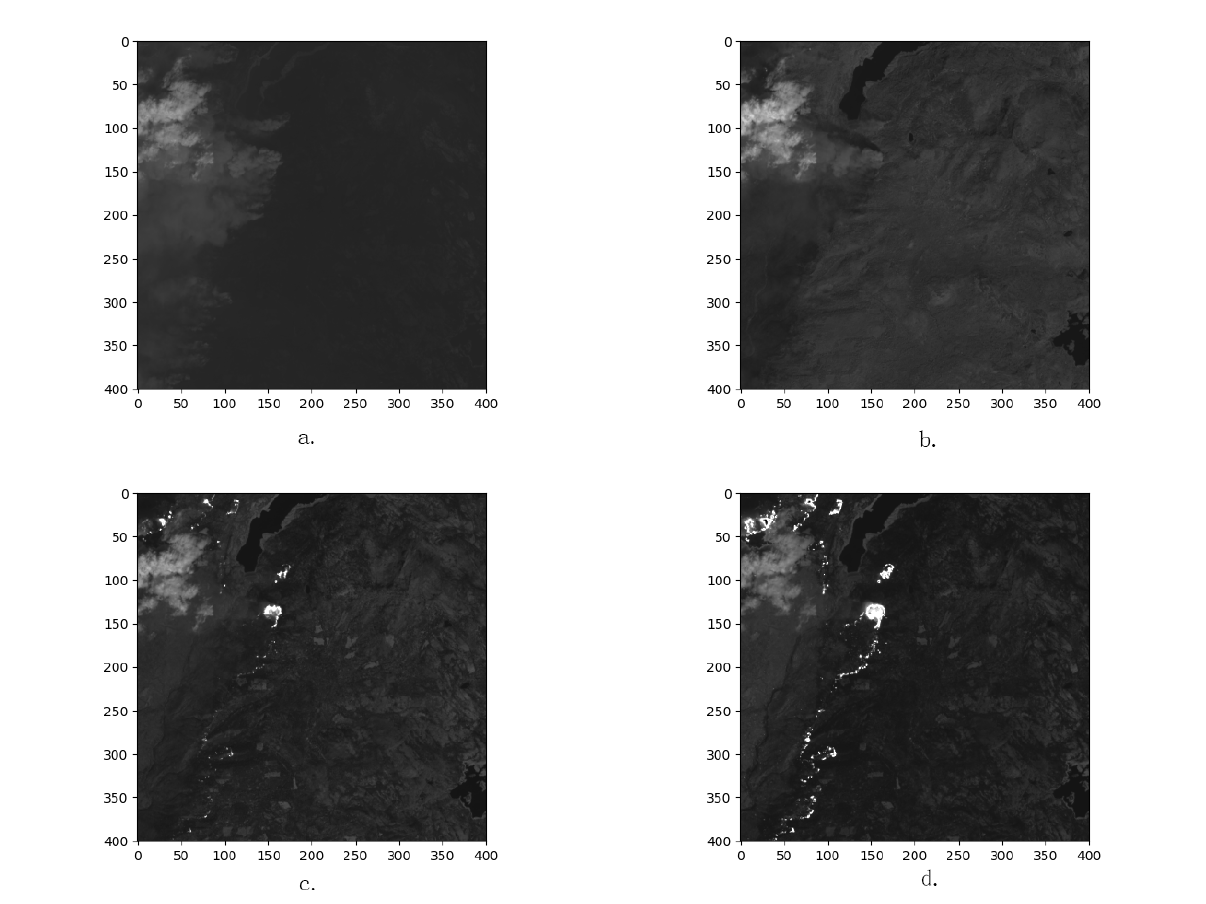
Figure 3. The bands used for fire detection. From a to d: band 1, band 5, band 6, and band 7. layer, several hidden layers and an output layer. It is capable of learning features of pixels following simple rules to update the weight in its nodes.